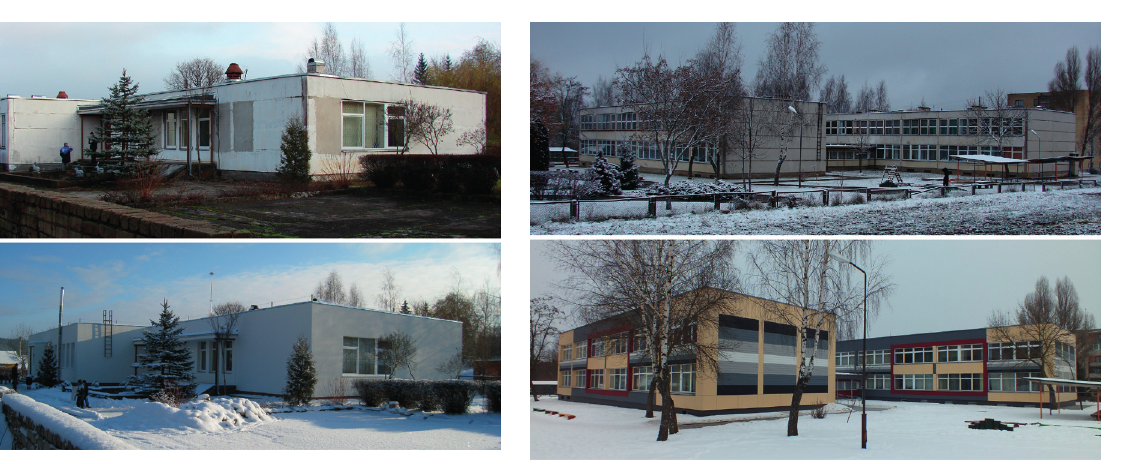
Fig. 3. Nursery school Saulutė in Molėtai before and after